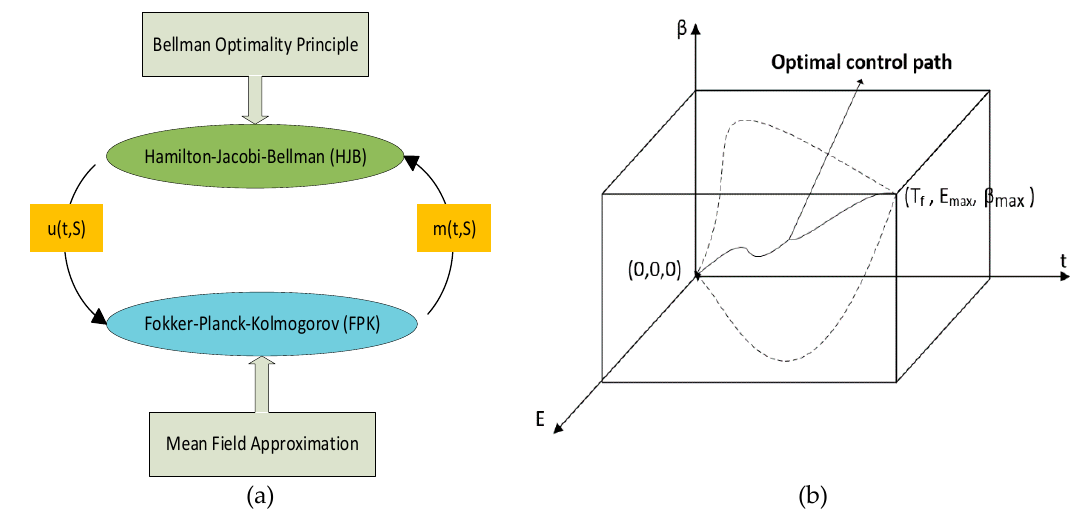
Figure 3. Mean Field Game, (a) Interaction model, (b) Optimal power control solution.